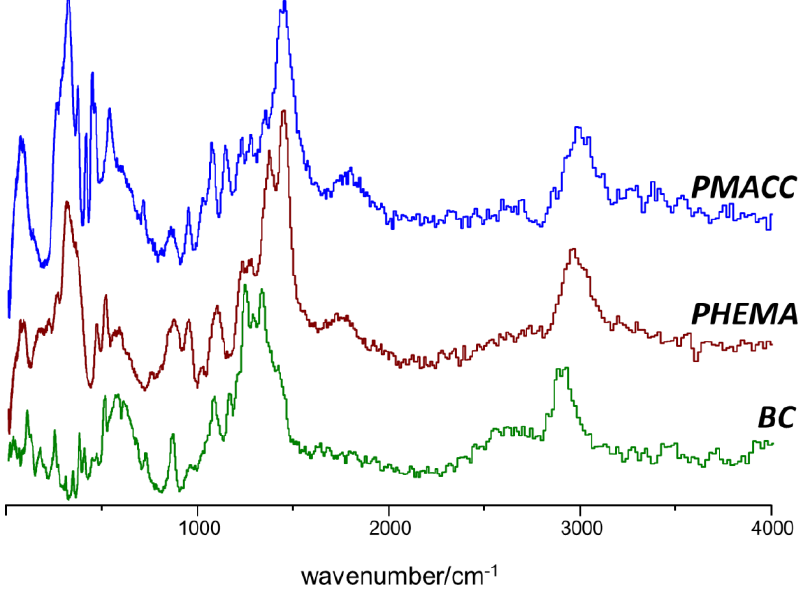
Figure 2. Inelastic neutron scattering (INS) spectra of PMACC (top), PHEMA (middle) and BC (bottom) in the 20–4000 cm −1 range (arbitrary intensity units).